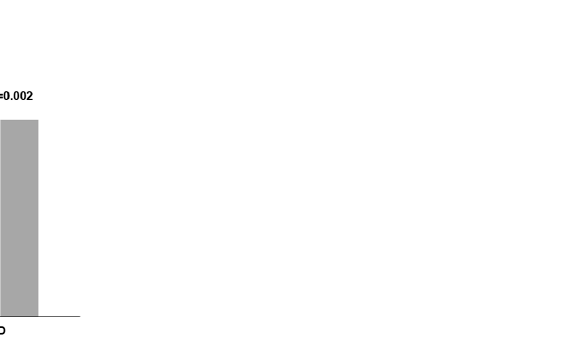
Figure 5. Percentage of the participants with high body fat mass. ( A ) According to energy intake. ( B ) According to protein intake. ( C ) According to a plant-based diet.